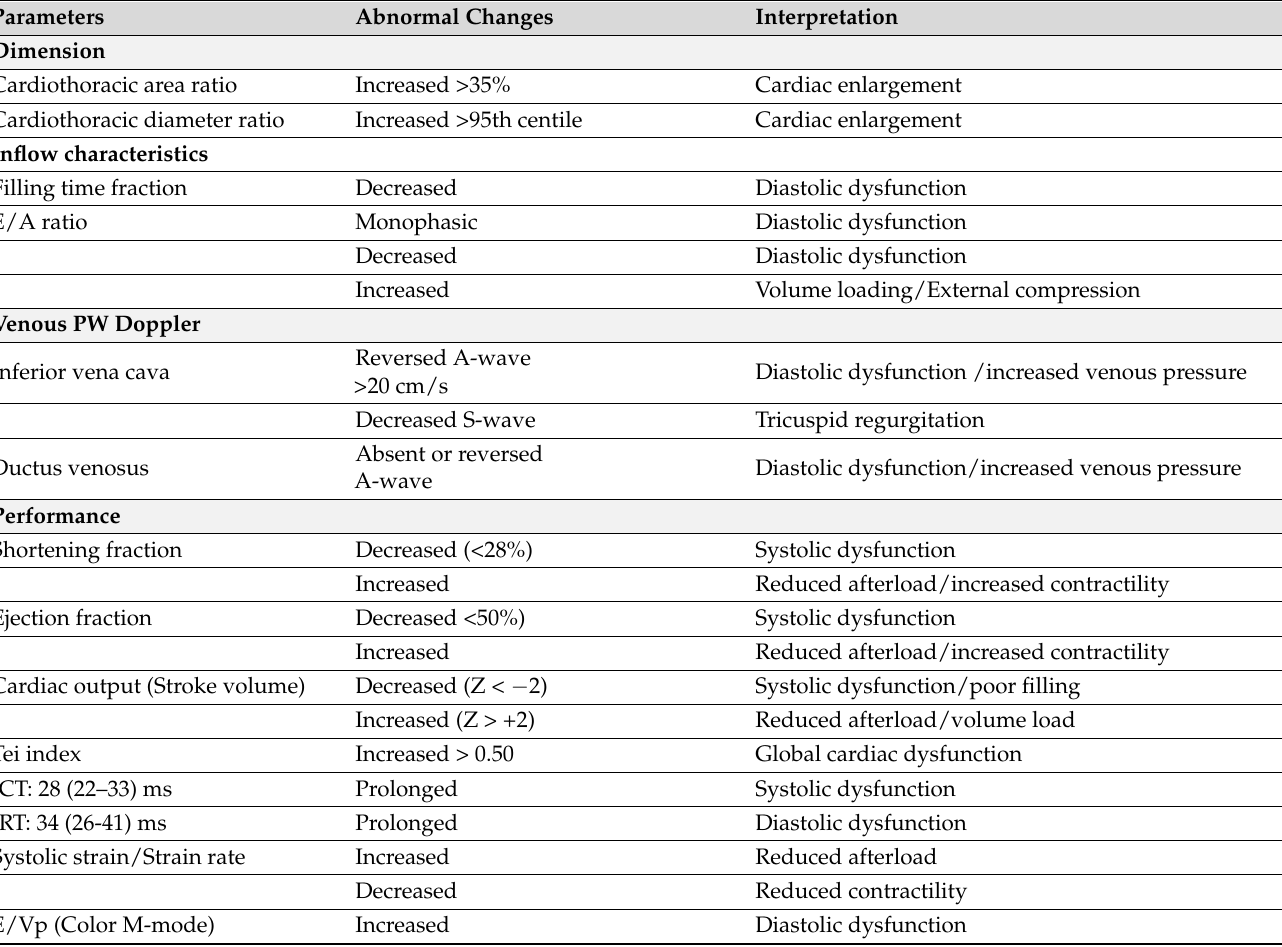
Table 1. Parameters for evaluation of fetal cardiac